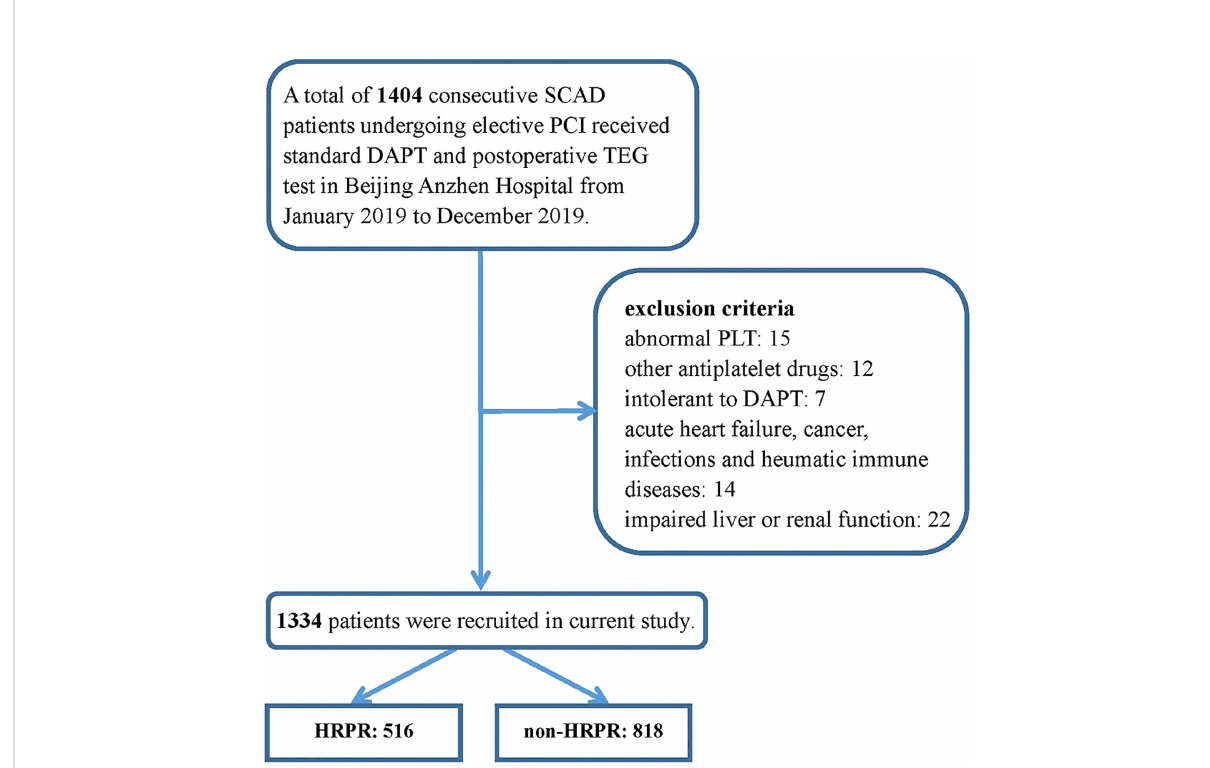
FIGURE 1 Inclusion and exclusion in the study population.SCAD, stable coronary artery disease; PCI, percutaneous coronary intervention; DAPT, dual antiplatelet therapy; TEG, thromboelastography; PLT, platelet